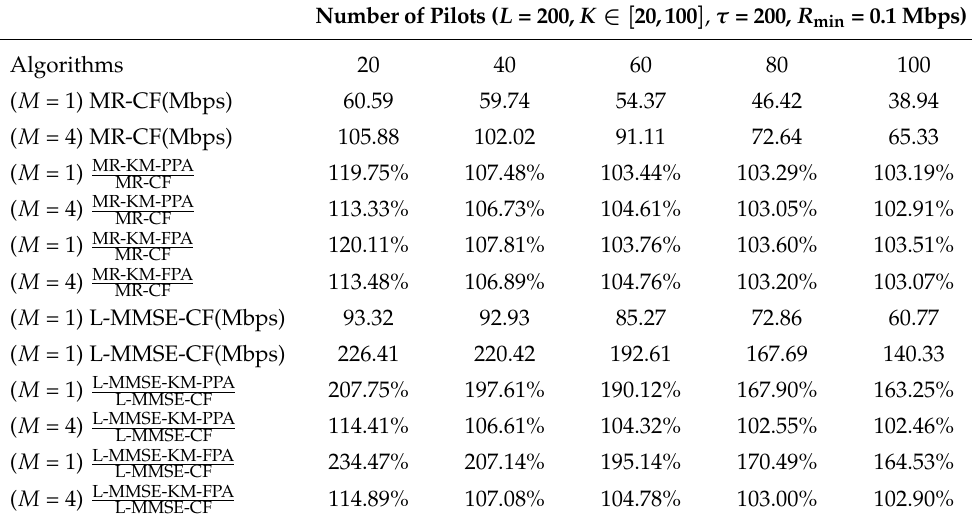
Table 3. The sum rates of IoT devices (IoTDs) with different numbers of pilots.